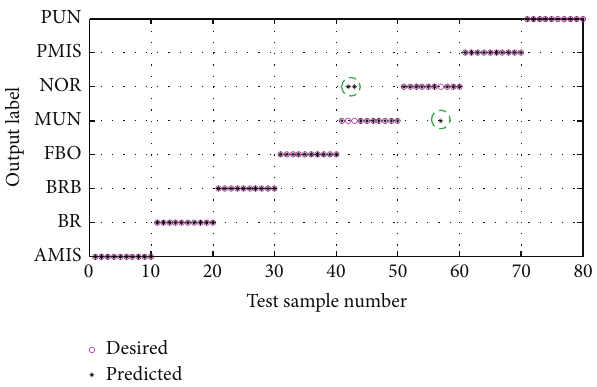
Figure 12: Accuracy of the proposed model for induction motor fault diagnosis.